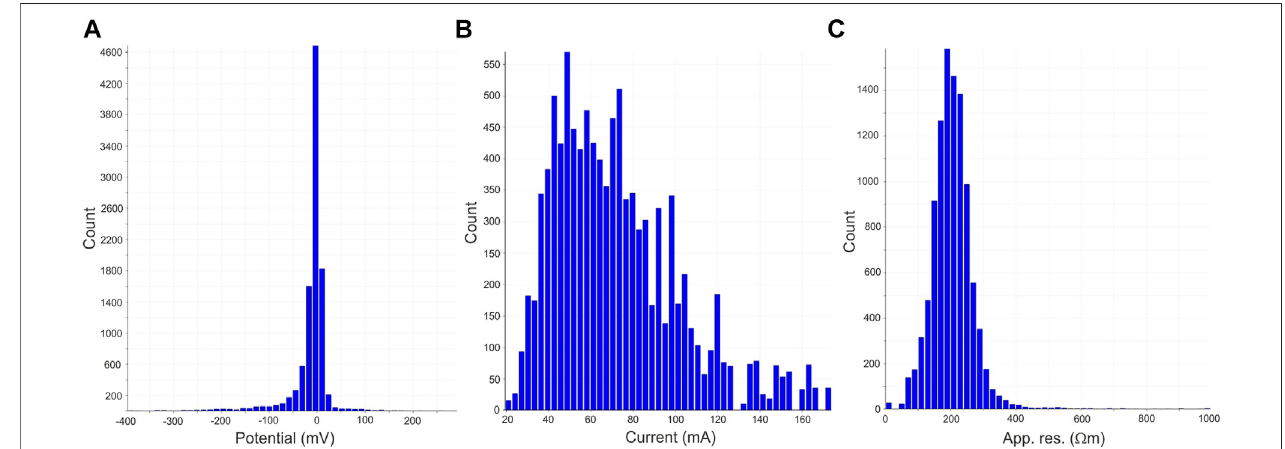
FIGURE 3 | Histograms of (A) potentials, (B) injected currents, and (C) apparent resistivities.